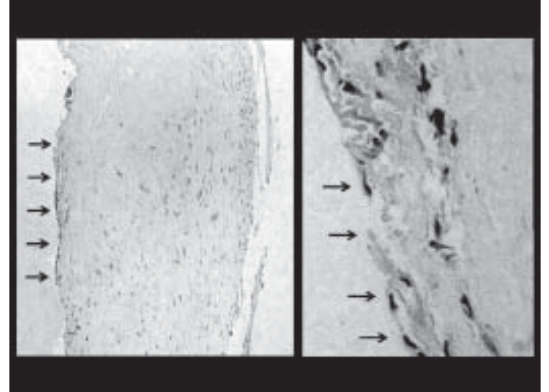
lumen.Fig. 6 - Histological study of the distal coronary arterial wall at the implantation site of a stent coated with rapamicin, exhibiting intense fibrotic process, with cellular degeneration and proliferation of the extracellular matrix, suggestive of an accentuated inflammatory